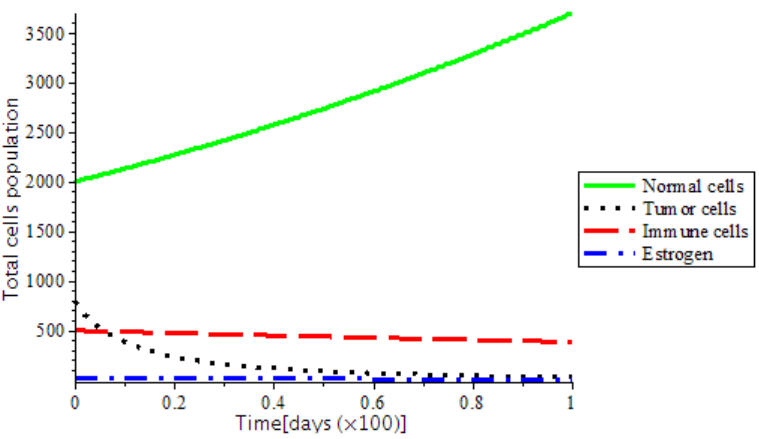
Figure 8. The variation of Total cells population depicted as locally asymptotically stable.